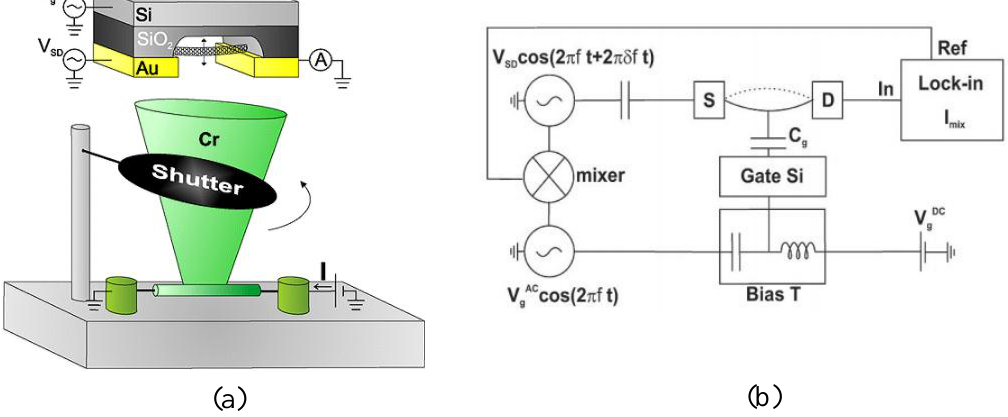
Figure 5. Schematics of the experimental setup and the measurement circuitry. Adapted with permission from [32], Copyright ACS, 2008.